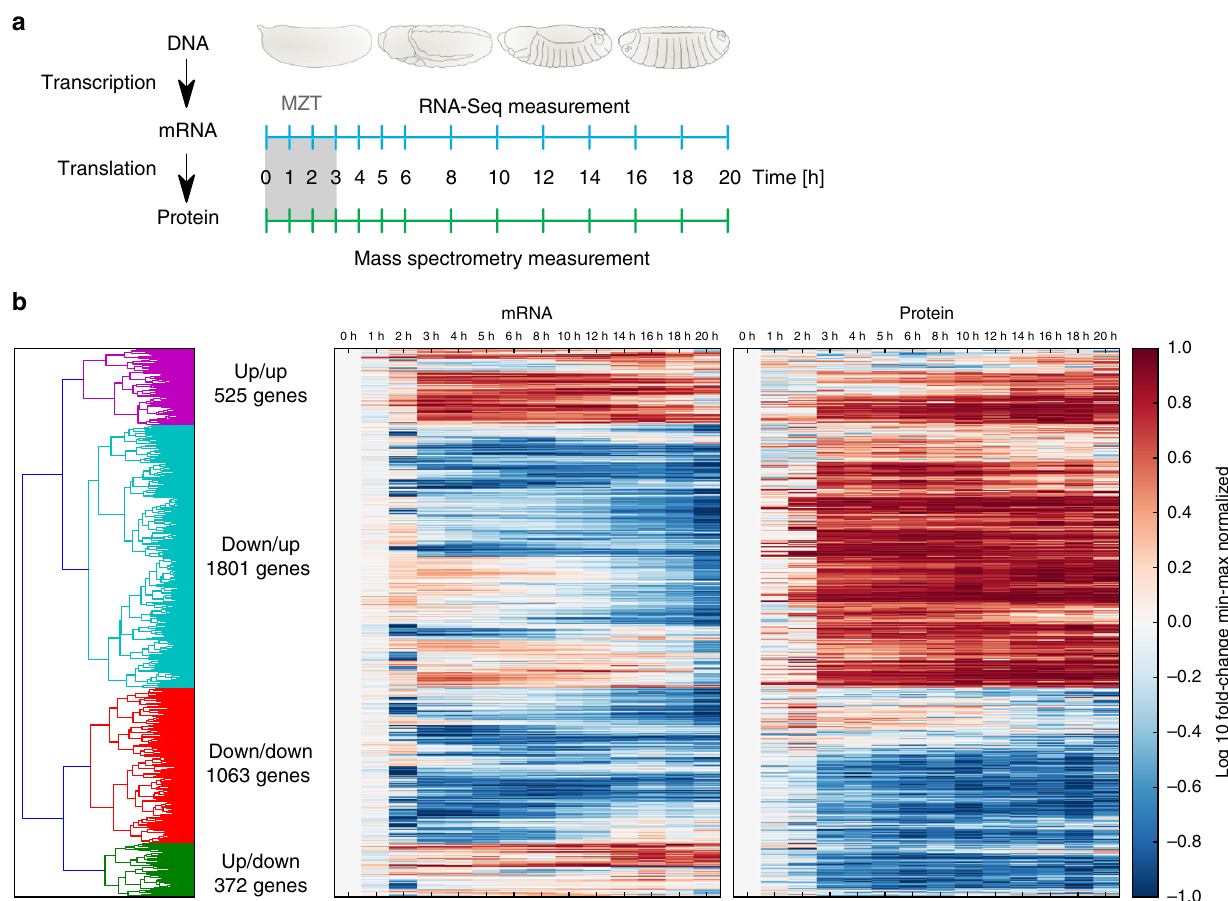
Fig. 1 Paired transcriptome and proteome of Drosophila embryogenesis. a Time-points of paired mRNA and protein measurements during Drosophila embryonic development using RNA-Seq and mass spectrometry, respectively. The initial time point (0 h) represents egg deposition; the maternal-to- zygotic transition (MZT) occurs within the fi rst 3 h of development. b Heatmaps of mRNA and protein time courses. The 3761 mRNA/protein pairs ( y -axis), for which protein could be quanti fi ed in at least 10 of 14 time points, are shown for the developmental time points ( x -axis). The color code indicates the mRNA and protein fold-changes relative to t = 0 h after min-max normalization between − 1 and 1. Time courses are sorted according to hierarchical clustering using the Euclidean distance (see also dendrogram on the left). Time courses within each of the four clusters (green, red, blue, purple) roughly follow similar dynamics, re fl ecting concordant or opposing mRNA and protein dynamics (increase (up) or decrease